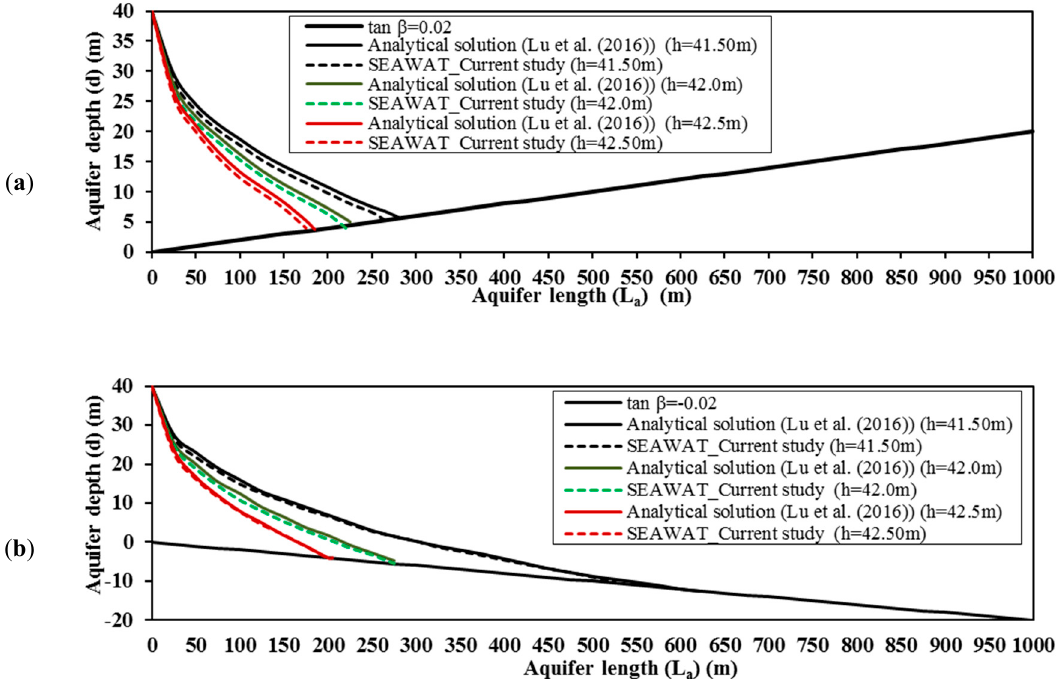
Figure 2. Comparison between the analytical and numerical results (SEAWAT) for the SWI interface in the steady state for a sloping bed unconfined aquifer: ( a ) positive sloping bed (tan β = 0.02) and ( b ) negative sloping bed (tan β = − 0.02) [49].